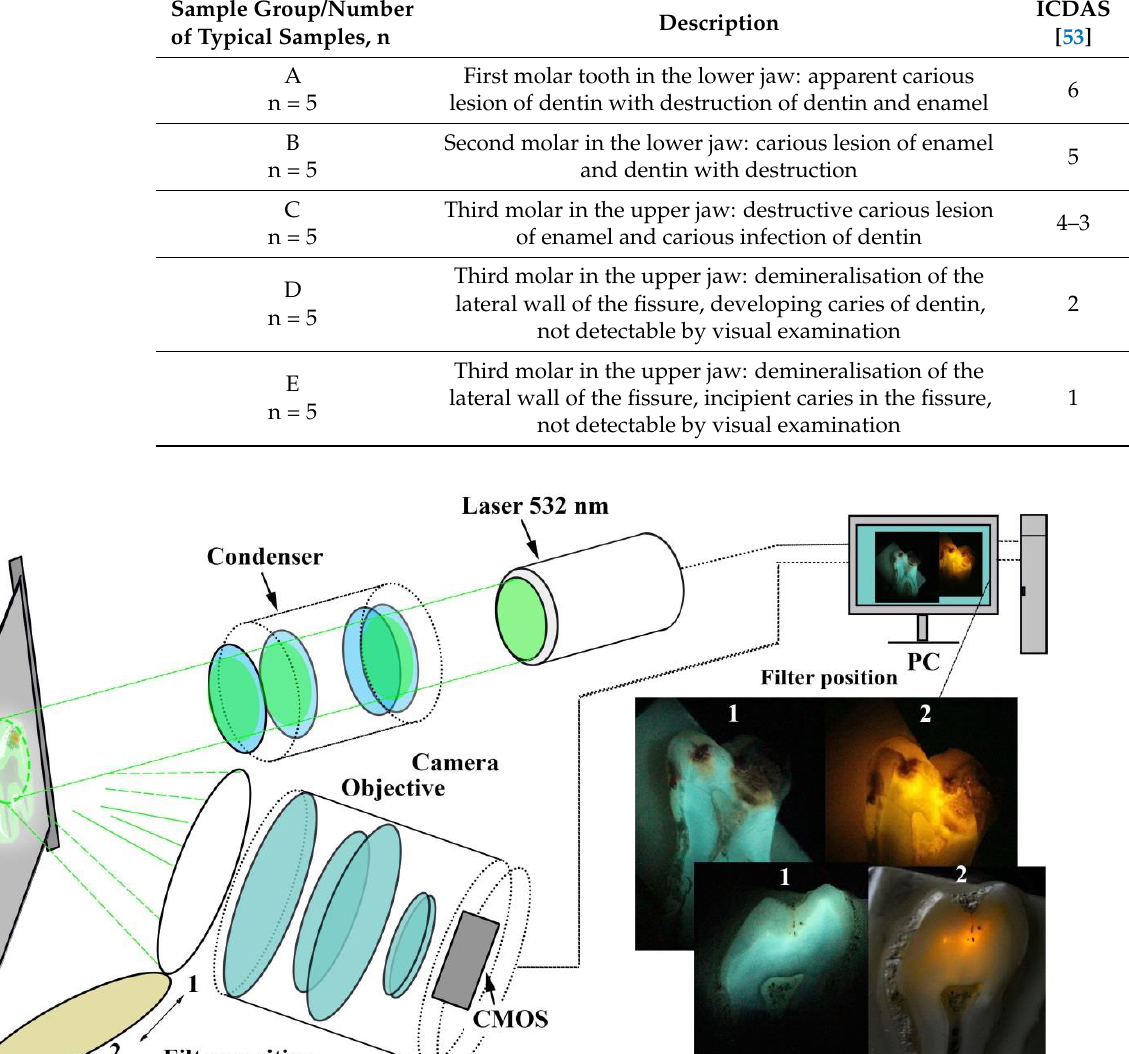
Table 1. Description of the samples studied and their classification. Sample Group/Number